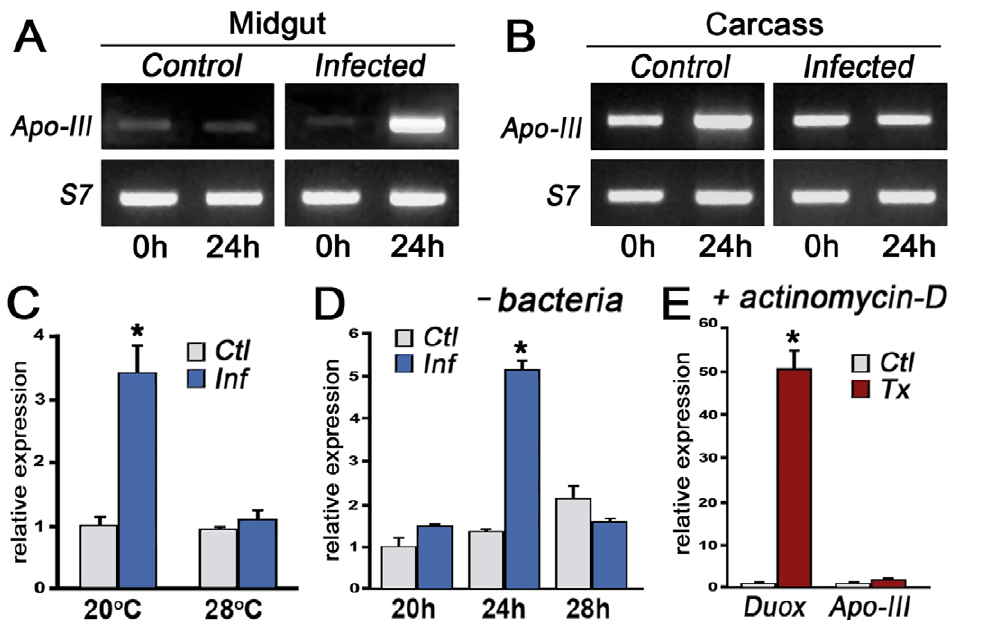
Figure 3. AgApoLp-III expression in response to blood feeding and Plasmodiumberghei infection in Anophelesgambiae (G3 strain) females. (A) AgApoLp-III mRNA expression in midguts of female mosquitoes fed on a healthy (control) or a P. berghei -infected mouse. Samples were collected immediately (0 hour) or 24 hours post feeding. Ribosomal S7 protein was amplified as reference. (B) Same as (A) but in carcass samples collected from the same mosquitoes. (C) AgApoLp-III expression in control and infected midguts kept at a temperature permissive for ookinete development (20 u C) or at a non-permissive temperature (28 u C). (D) Time course of AgApoLp-III induction in female mosquitoes in which gut microbiota have been removed with oral antibiotics. (E) Effect of actinomycin D-induced apoptosis on mRNA expression of dual oxidase (Duox) and AgApoLp-III (Apo-III).